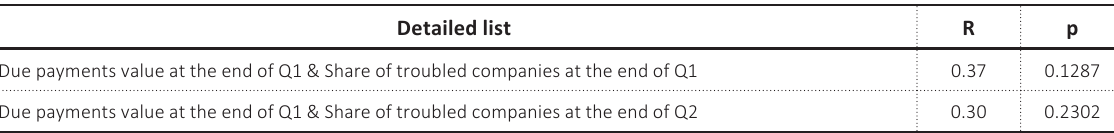
Table 3. Spearman’s rank correlation coefficient between due payments in Q1 and Q2 and the